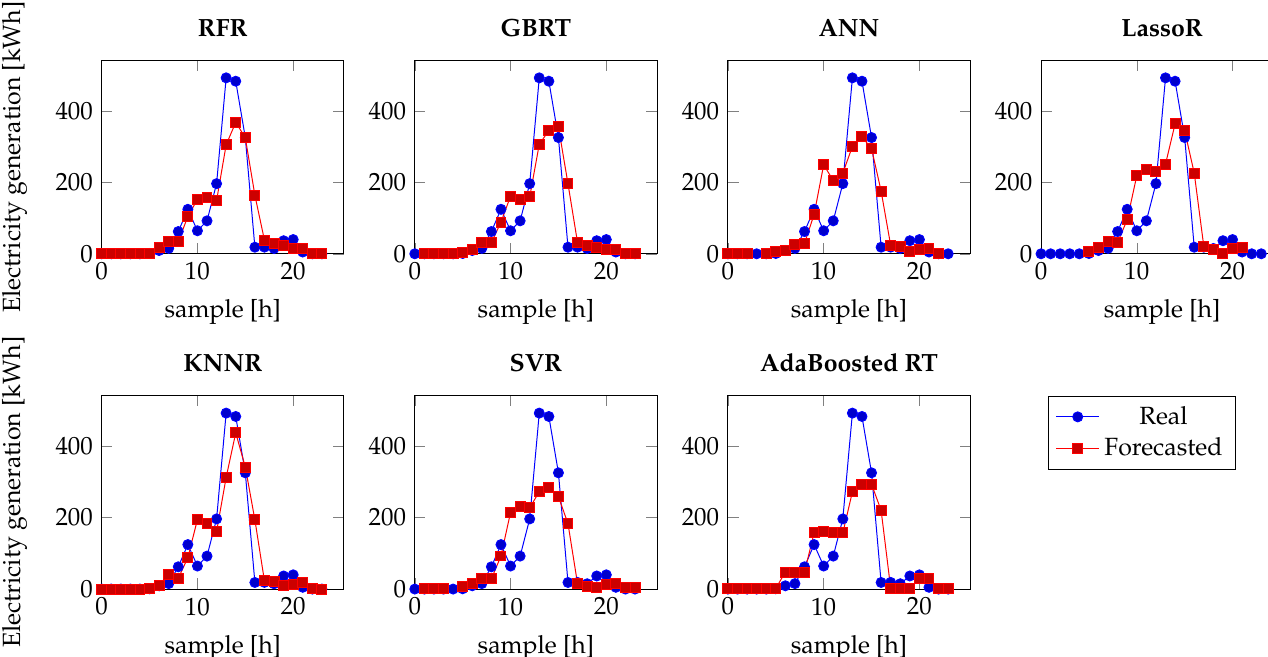
Figure 4. Forecasting results for a chosen day in which medium compliance was